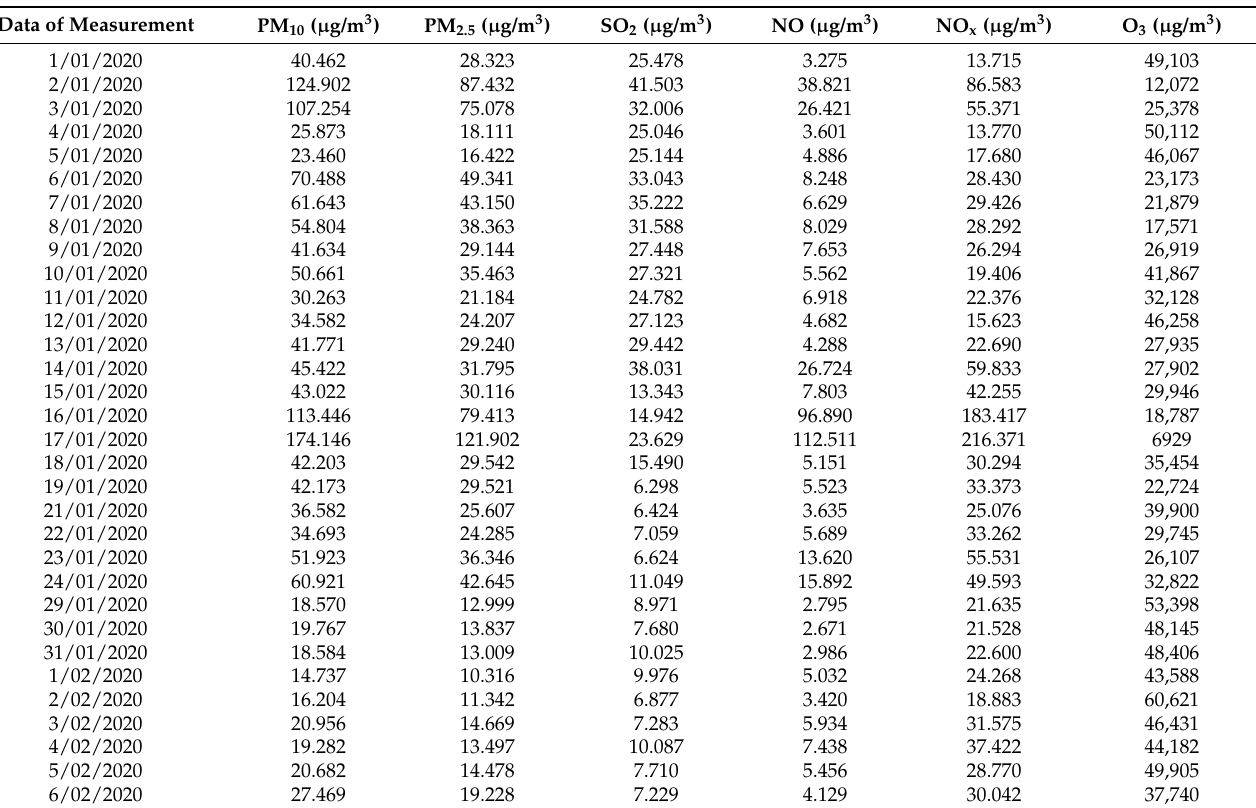
Table 1. The lists of the measured values of PM 10 ( µ g/m 3 ), PM 2.5 ( µ g/m 3 ), SO 2 ( µ g/m 3 ), NO ( µ g/m 3 ), NO x ( µ g/m 3 ) and O 3 ( µ g/m 3 ) (average daily). Data of